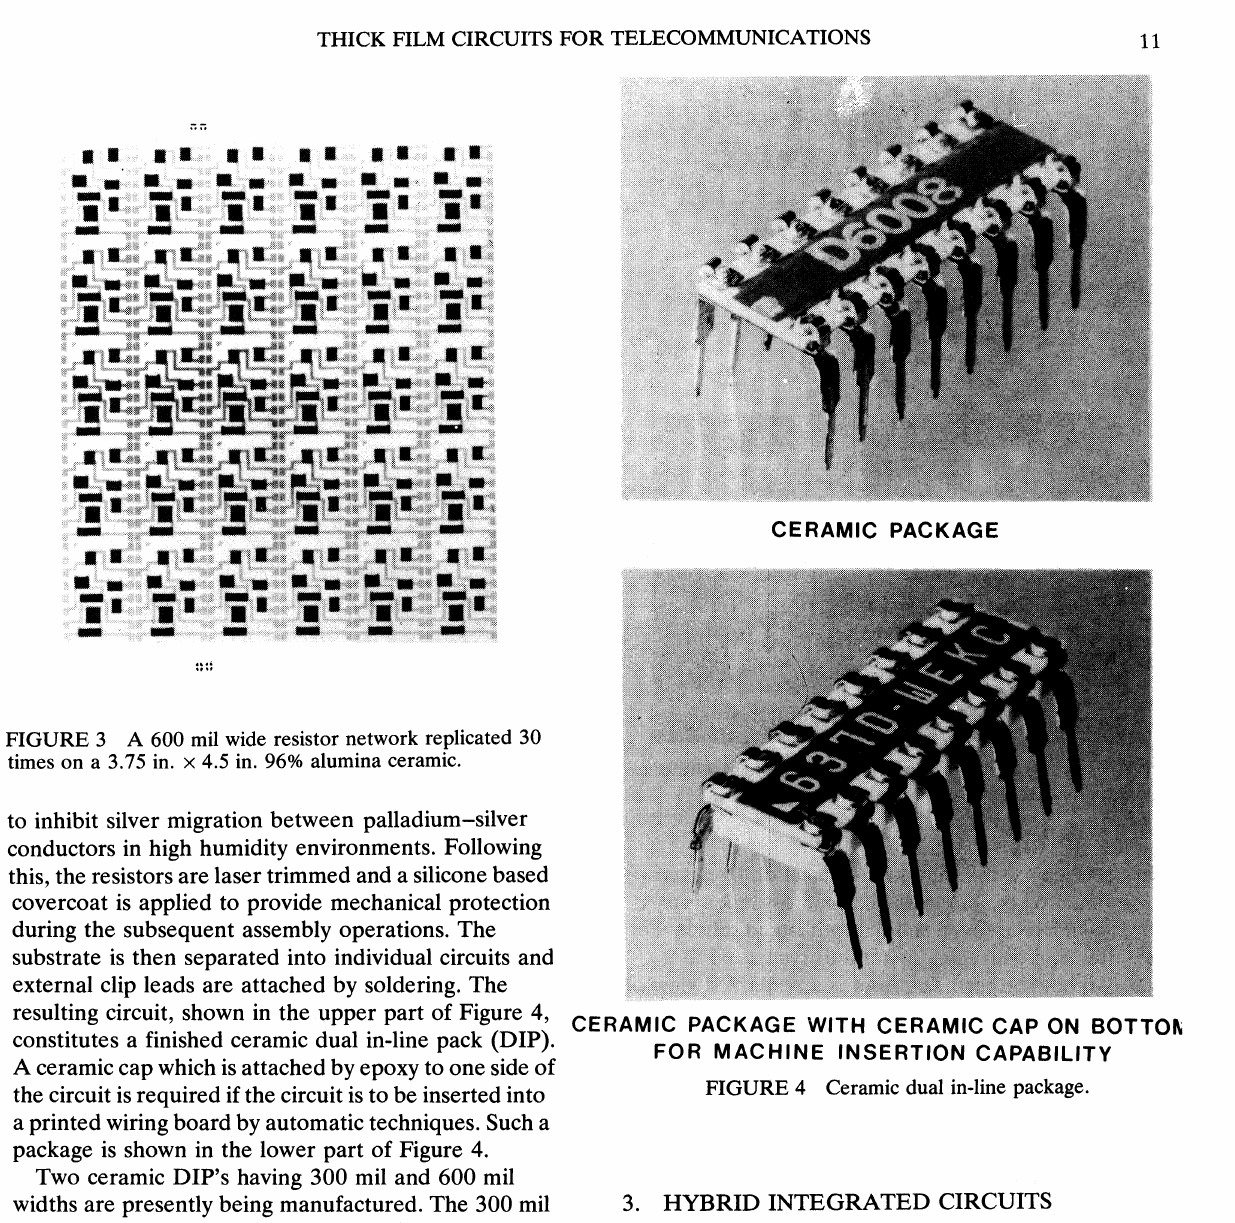
FIGURE 4 Ceramic dual in-line